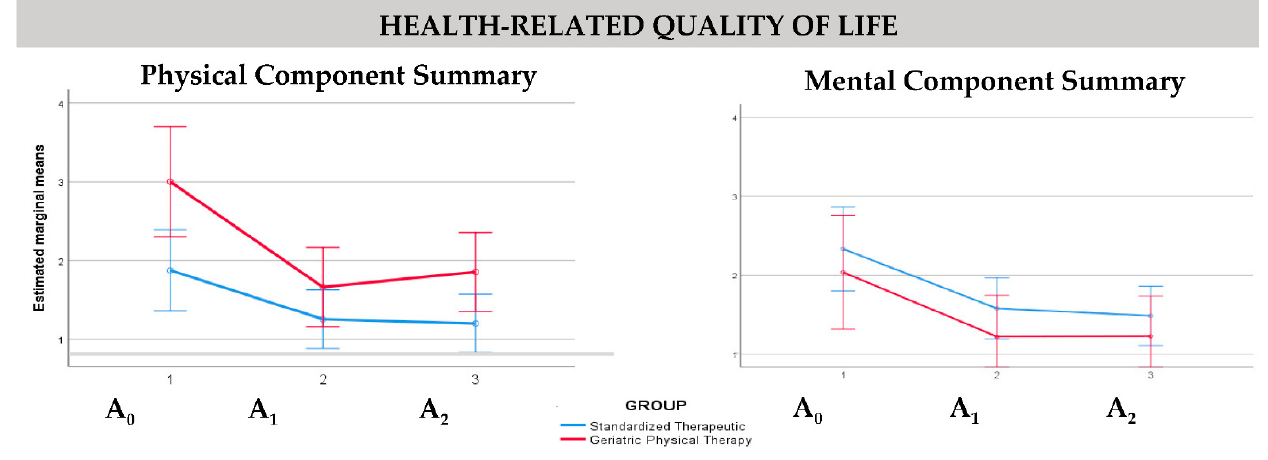
Figure 2. Estimated marginal means of health-related quality of life at baseline (A 0 ), post-interven-